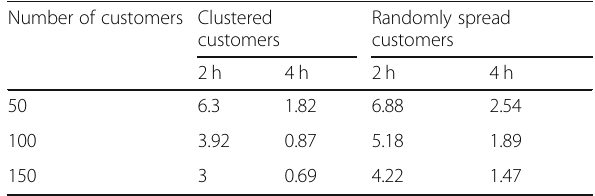
Table 6 Average increase in cost per customer for selecting a delivery time window